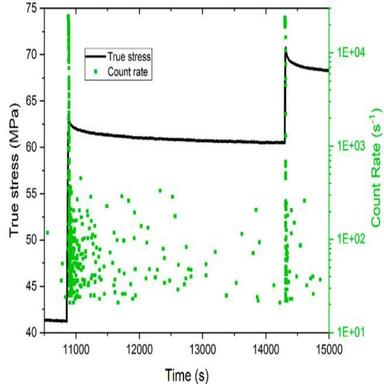
The correlation of the time dependency of true stress and the AE count rate in the 45° sample during preceding loading, stress relaxation during diffraction spectra collection, and succeeding loading.